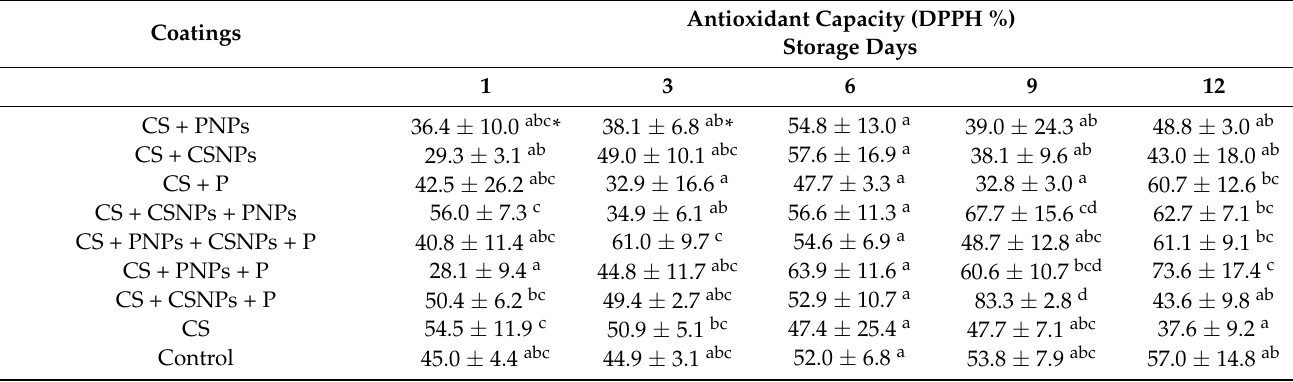
Table 4. Effect of edible chitosan/propolis coatings on the antioxidant capacity of fig fruit stored for 12 days at 4 ◦ C.